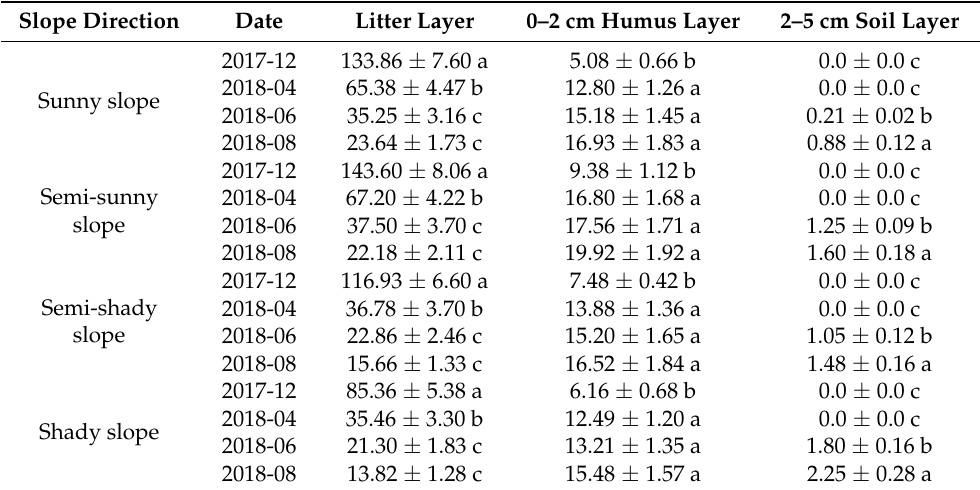
Table 5. Vertical distribution of Castanopsis hystrix soil seed bank on different slope directions (seeds · m − 2 ).